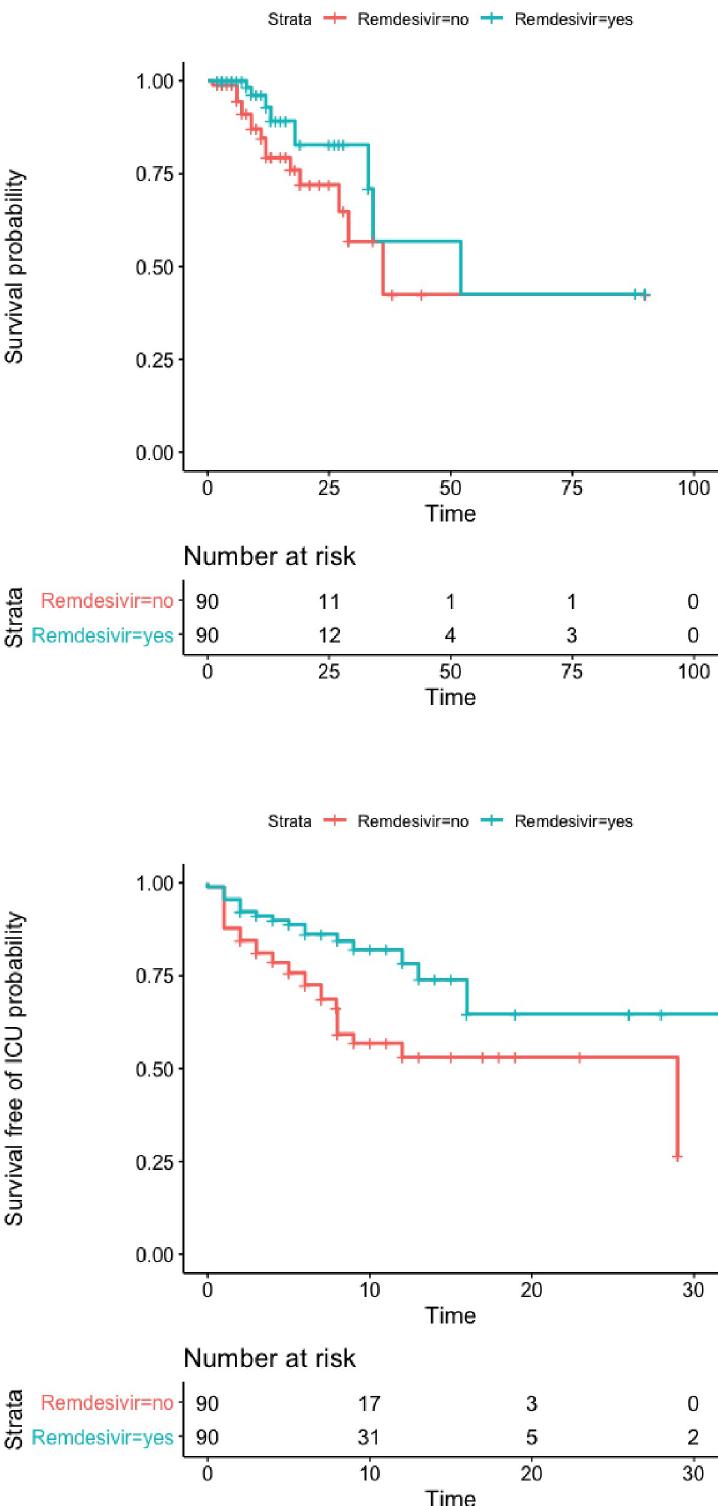
Fig 1. Estimated outcomes (survival in upper plot, survival free of transfer to the ICU in lower plot) in the matched cohort.